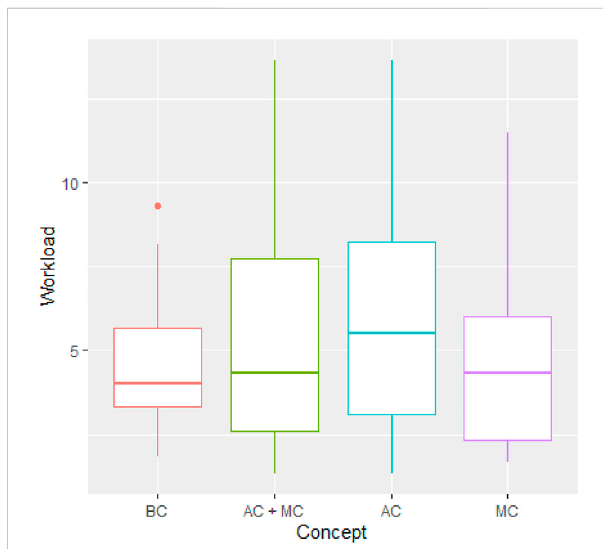
FIGURE 9 Boxplots for the workload scores depending on the HMI concepts.